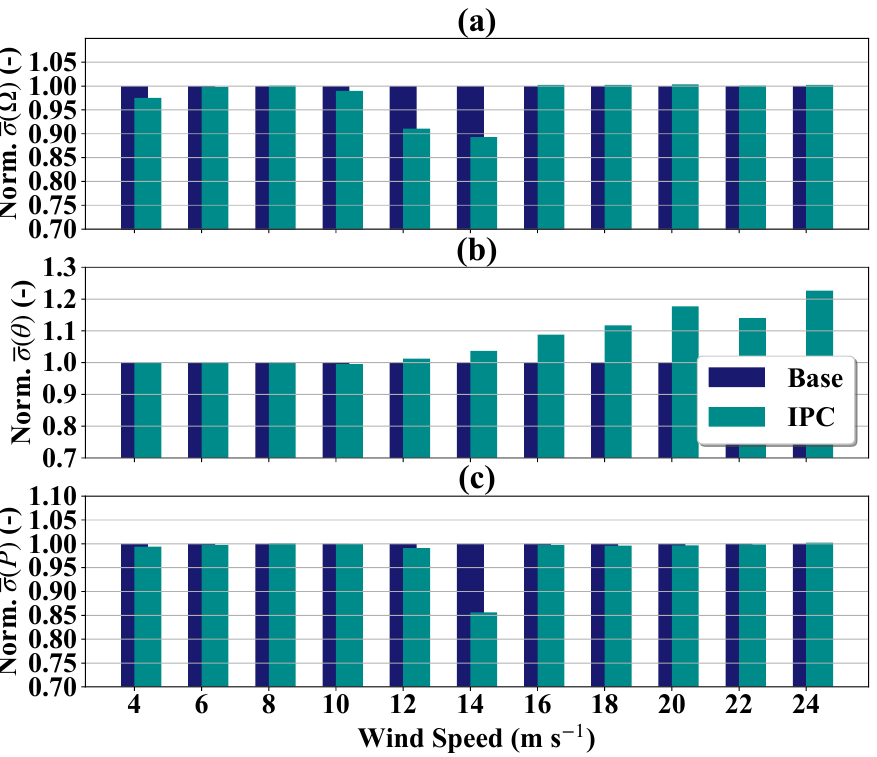
Figure 12. Averaged standard deviations of controller signals vs. wind speed. ( a ) Rotor speed; ( b ) Pitch angle; ( c ) Generator power. Nomenclature of the signals is found in Table 5. Base = CPC